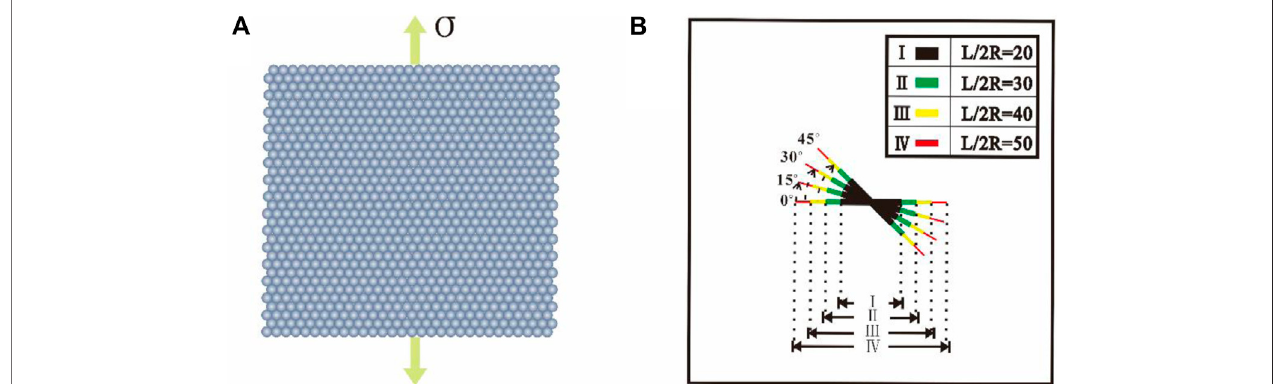
FIGURE 6 | Loading path and single crack diagram. (A) Uniaxial tensile test. (B) Single-crack design.